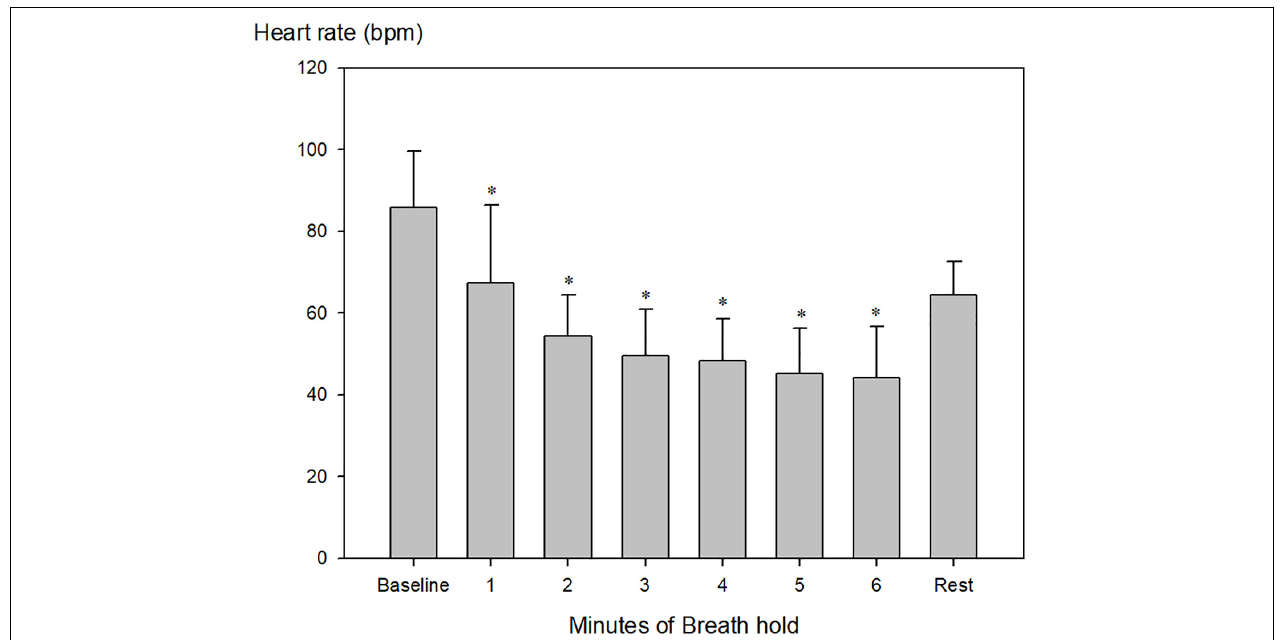
FIGURE 2 | Heart rate during maximum pool apnea. Heart rate decreased from 86 ± 14 beats per minute (bpm) to 46 ± 10 bpm after the first 4 min of apnea compared to baseline and stabilized until termination of breath hold ( ∗ P < 0.001 compared to baseline, n = 9).